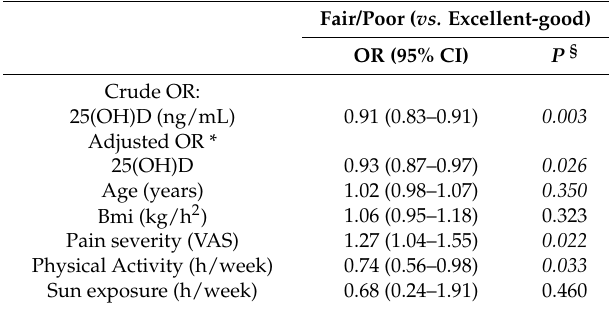
Table 3. The association between 25(OH)D (ng/mL) and self-rated health.